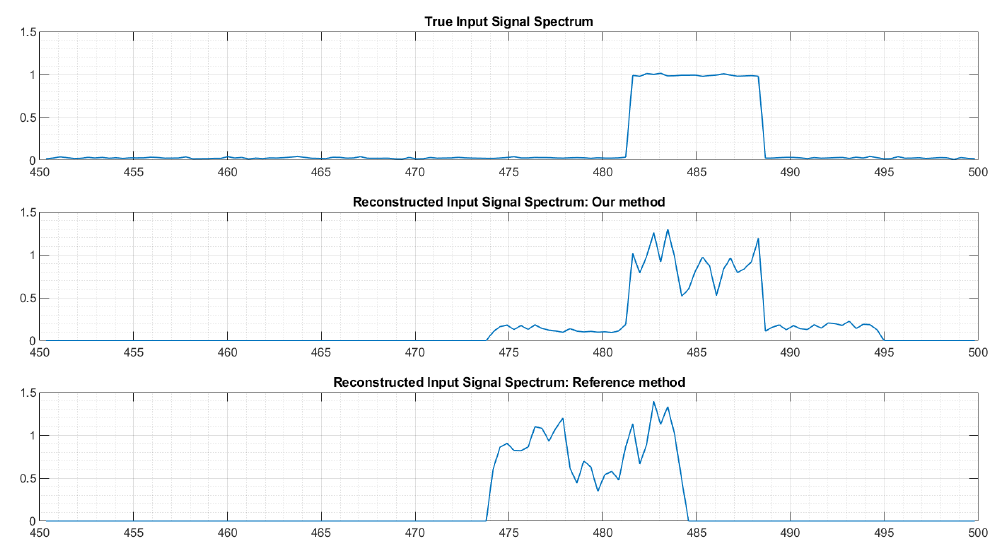
Figure 21. Example of spectrum reconstruction with 2 transmitters (zoom). The horizontal axes are frequencies, labeled in